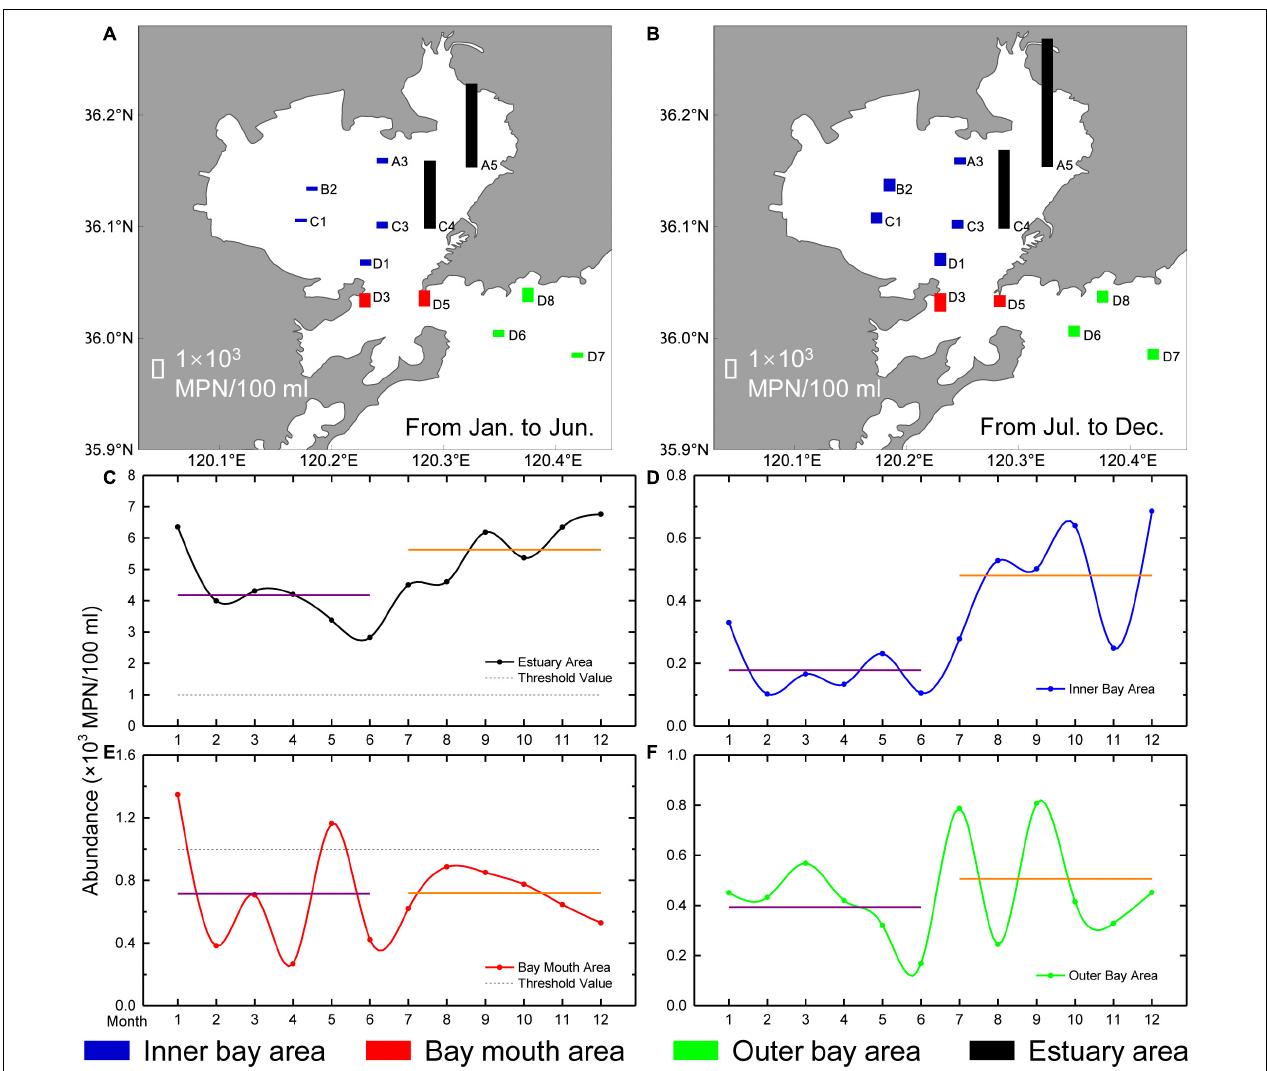
FIGURE 5 | Annual variation of CB abundance ( × 10 3 MPN/100 ml) in Jiaozhou Bay. The columns with various lengths in different sampling stations indicate the average abundance of CB during the investigating period: (A) in the first half of the year; and (B) in the second half of the year. Variations in the annual abundance of CB in four areas in Jiaozhou Bay: (C) the estuary area; (D) the inner bay area; (E) the bay mouth area; and (F) the outer bay area. The purple and orange lines represent the average abundances in the first and second halves of the year, respectively. The black dotted line (threshold value) represents the Class IV standard for CB abundance specified by the